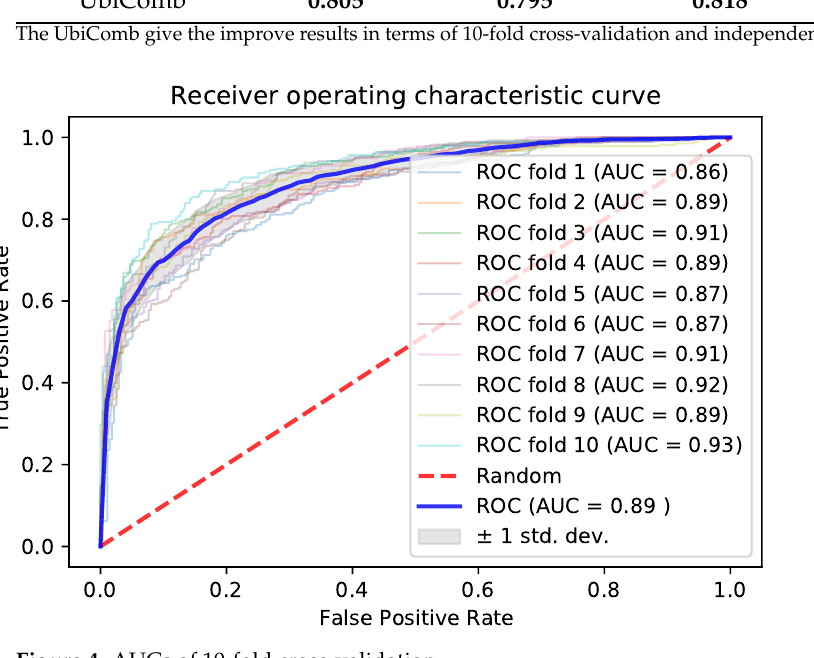
Figure 4. AUCs of 10-fold cross-validation.